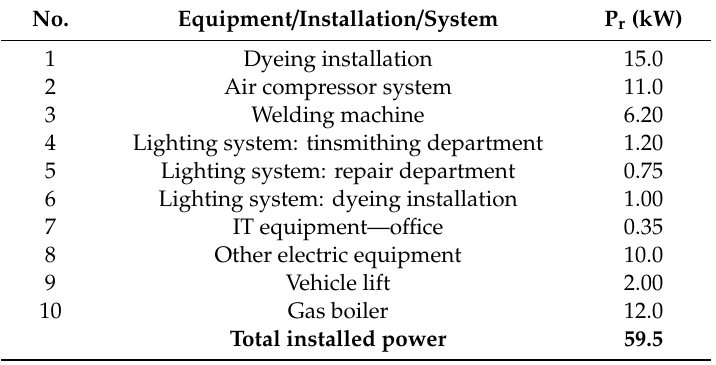
Table 3. The electrical equipment / installations / systems recorded in the